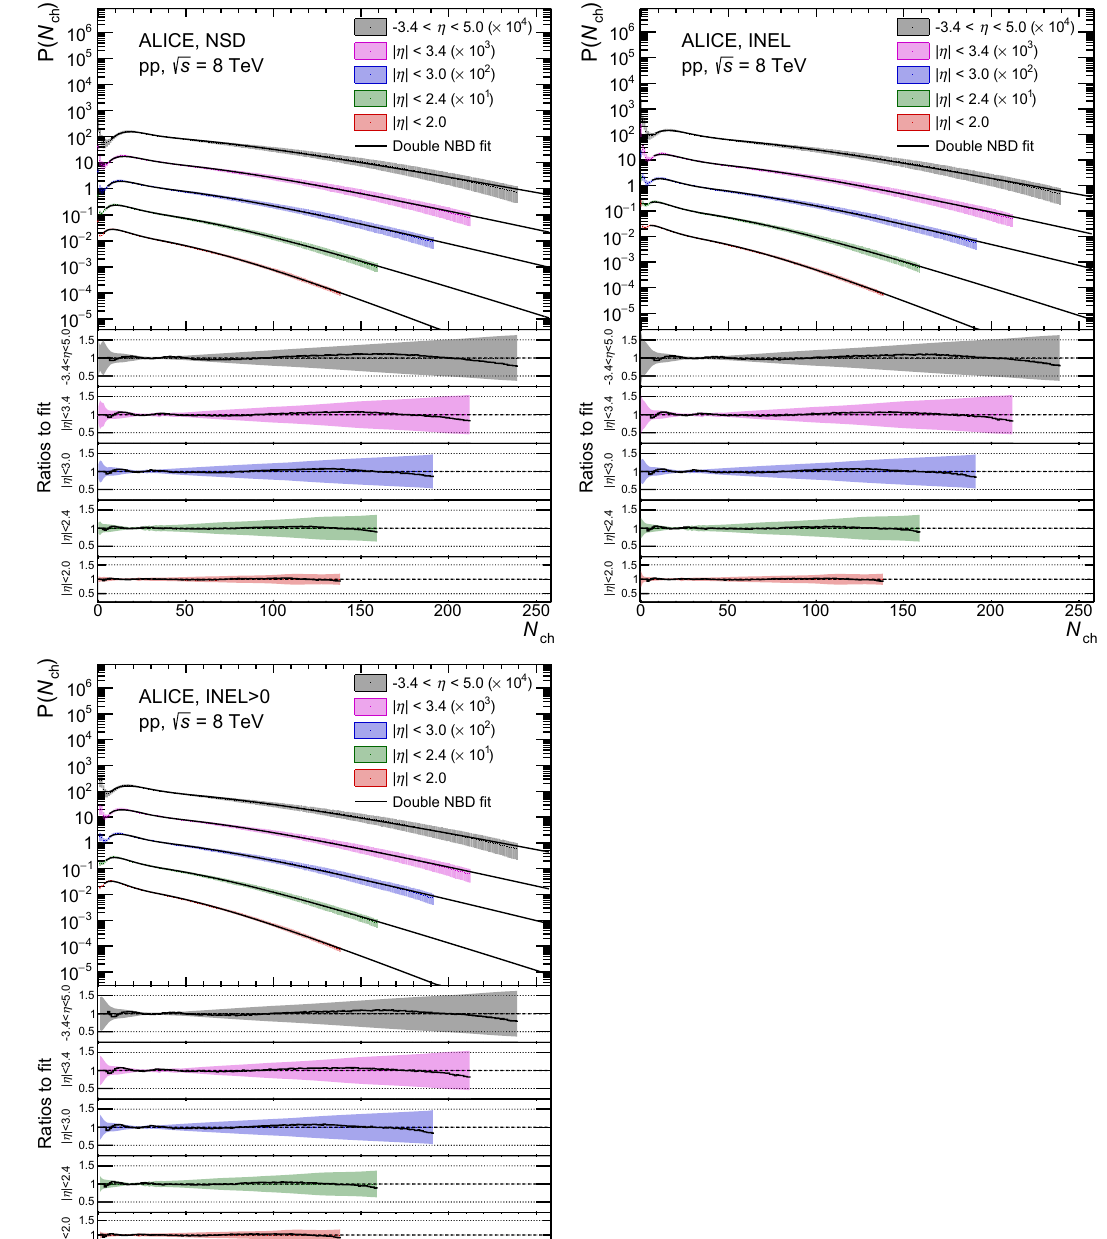
Fig. 5 Charged-particle multiplicity distributions for NSD (top left), INEL (top right) and INEL > 0 (bottom) pp collisions at The lines show fits to double NBDs. Ratios of the data to the fits are also